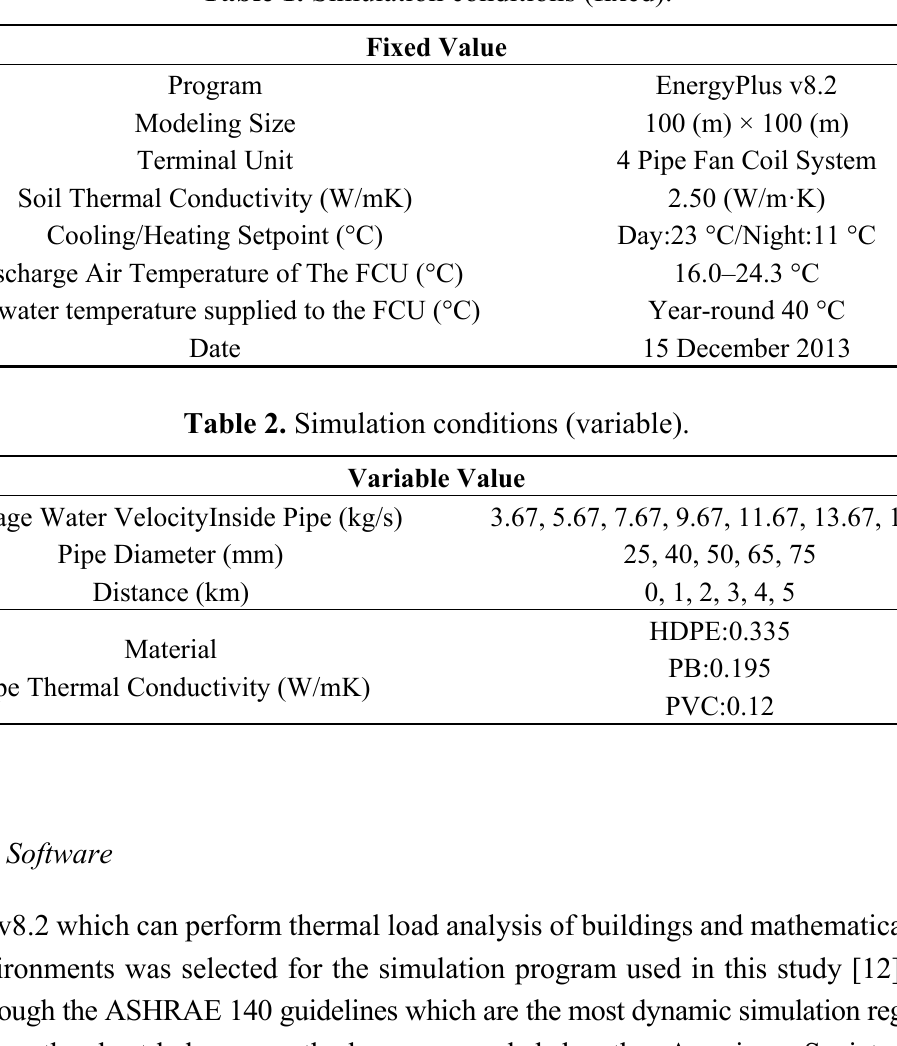
Table 1. Simulation conditions (fixed).